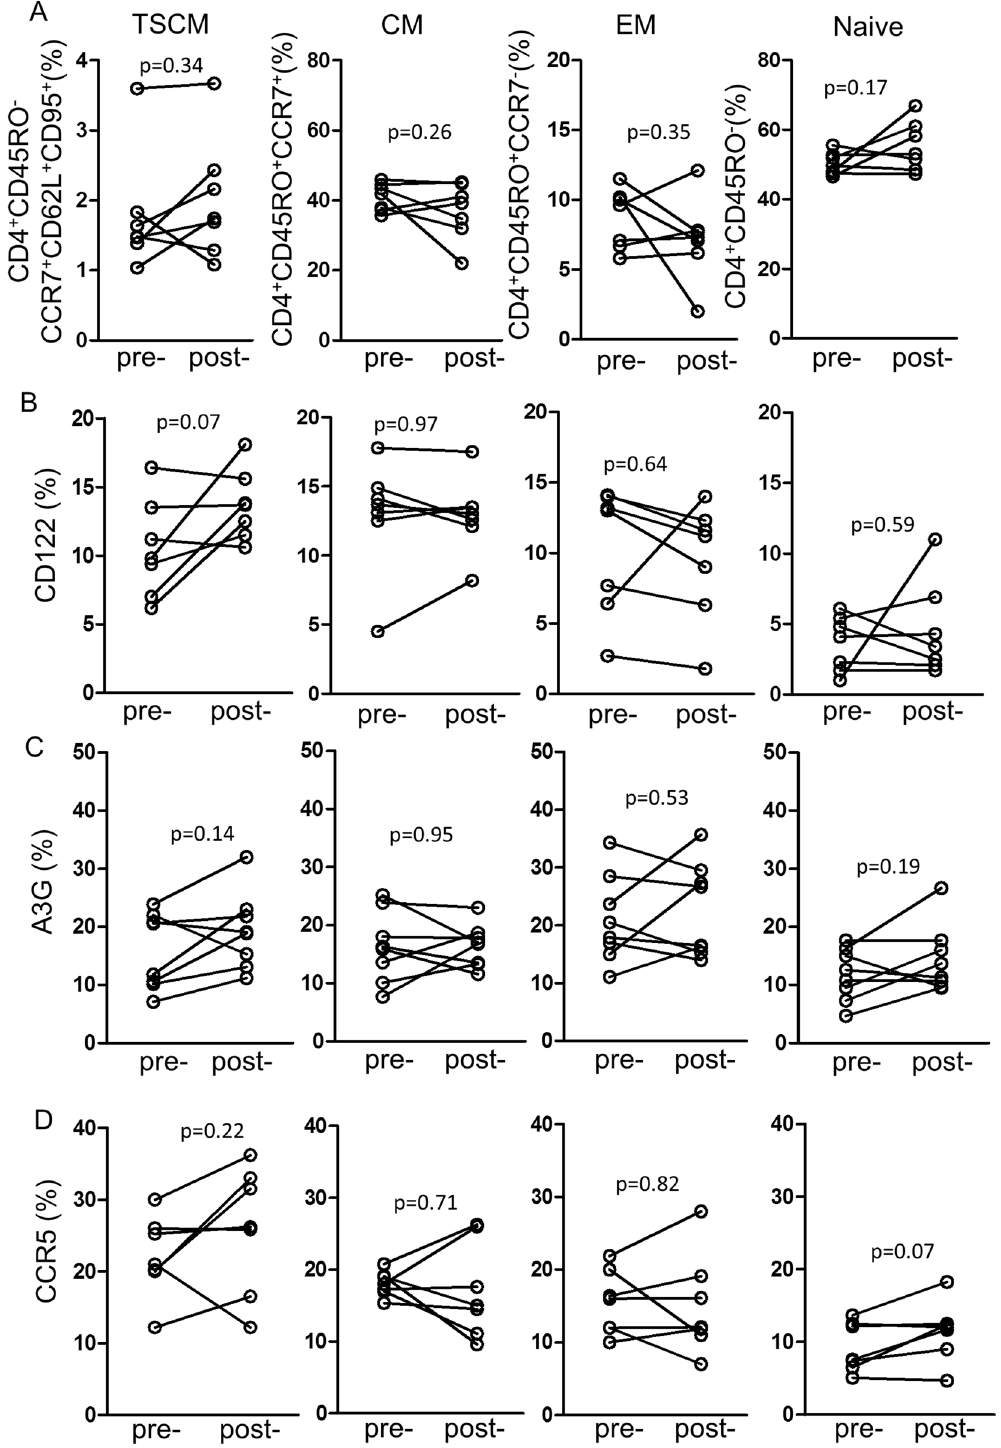
Figure 3. The effect of placebo on ( A ) TSCM, central, effector memory and naïve CD4 + T cells, ( B ) CD122, ( C ) A3G and ( D ) CCR5 in the corresponding CD4 + T cell subsets (n = 7) samples from different subjects but the comparison was as in Fig. 2. Gating and identification of these subsets of cells is similar to those illustrated in Fig. 2 ( E , F